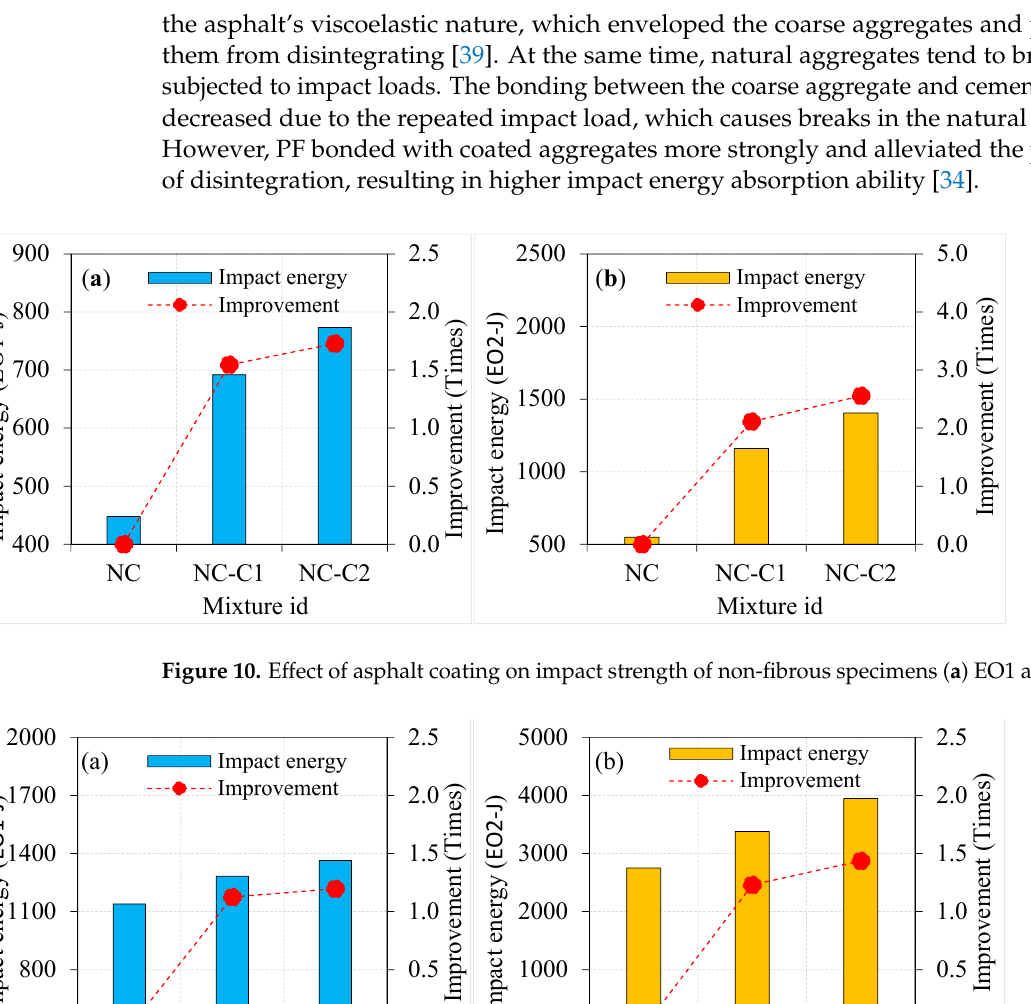
Figure 10. Effect of asphalt coating on impact strength of non-fibrous specimens ( a ) EO1 and ( b ) EO2.